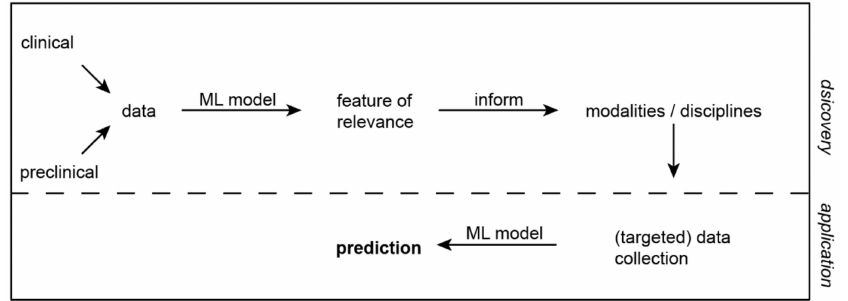
Figure 4. Future directions of machine learning in GEA. Within the discovery phase of machine learning, multi-omics approaches that are collecting data of various sources, including RNA and DNA sequencing, epigenetics, proteomics, imaging data, and metabolics will help to understand the TME, especially considering dynamic changes of cancer progression and treatment. These data will be integrated using machine learning and relevant information from all disciplines/modalities will be used to then inform the specialties what information (features) are necessary to apply specialized machine learning models that will predict individual disease traits, such as response to therapy and individual treatment